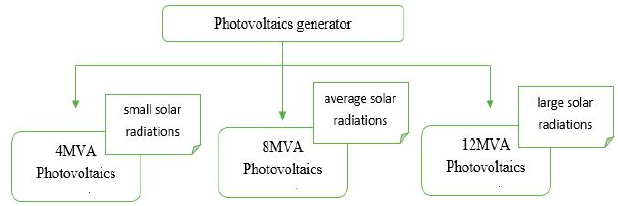
Figure 13. Types of photovoltaic generators.